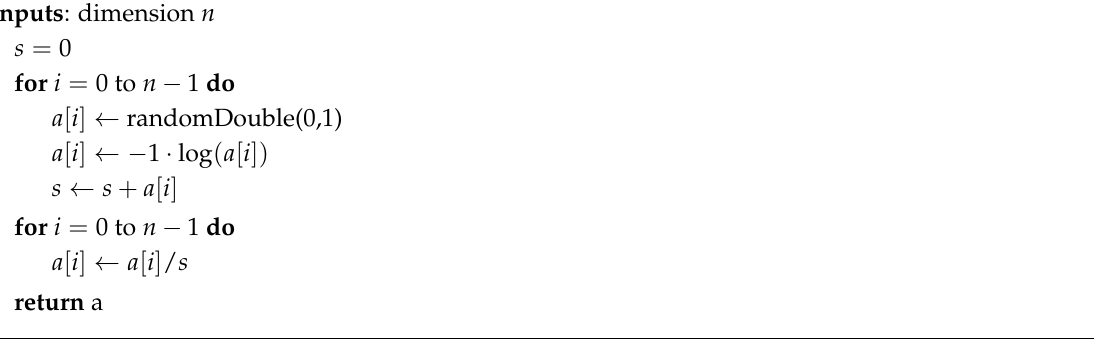
Algorithm 4 Generate point uniformly at random from n -dimensional simplex